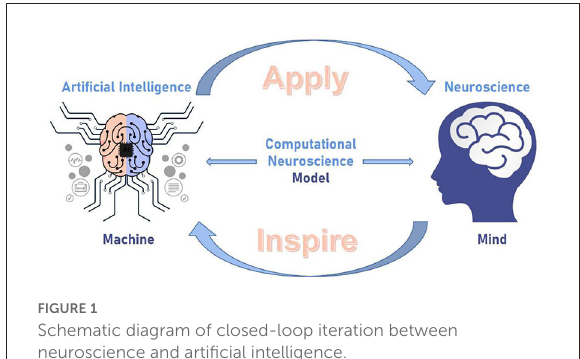
FIGURE1 Schematic diagram of closed-loop iteration between neuroscience and artificial